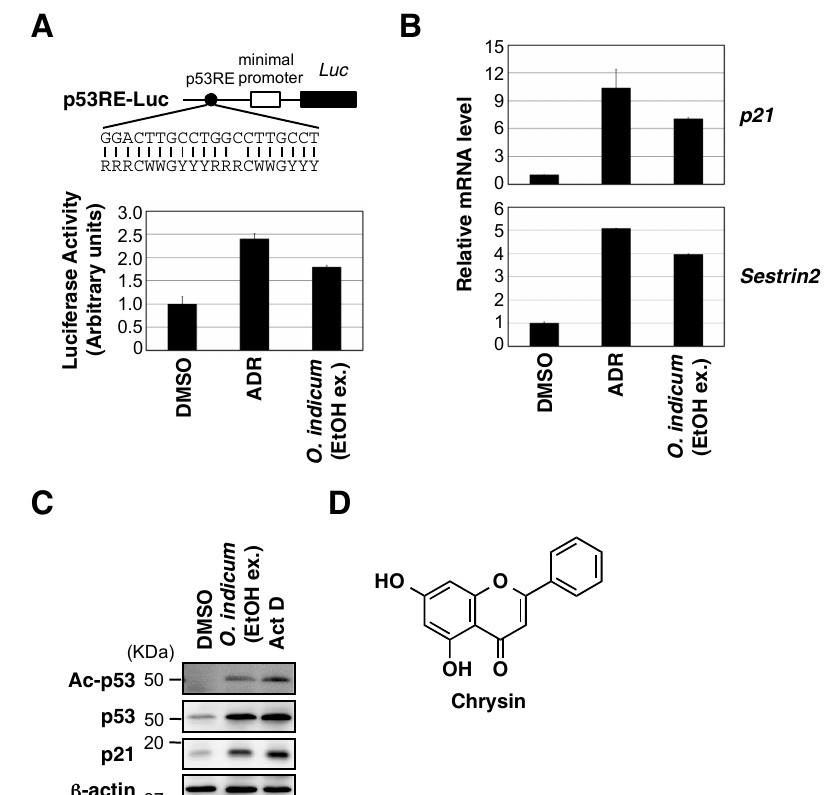
Figure 1. Ethanol extract of Oroxylum indicum bark increased p53 transcriptional activity. ( A ) The sequence of p53-responsive element (p53RE) in reporter construct is shown, and the consensus p53 binding sequence (W can be A or T, and R and Y strand for purine and pyrimidine bases, respectively) is shown below. MCF7 cells, stably expressing the p53-responsive luciferase reporter, were treated with ADR (0.3 µ M) or the ethanol extract (ex.) of O. indicum bark (100 µ g/mL). After 8 h, luciferase activities in cell lysates were measured. The experiment was run in triplicate, and data are represented as the mean fold activation ± S.D. ( B ) MCF7 cells were treated with ADR (0.3 µ M) or the ethanol extract of O. indicum bark (100 µ g/mL) for 8 h. The expression of each gene was assessed by qPCR. ( C ) MCF7 cells were treated with the ethanol extract of O. indicum bark (100 µ g/mL) or actinomycin D (Act D) (10 nM) for 8 h. Cell lysates were immunoblotted with the indicated antibodies. ( D ) Structure of chrysin